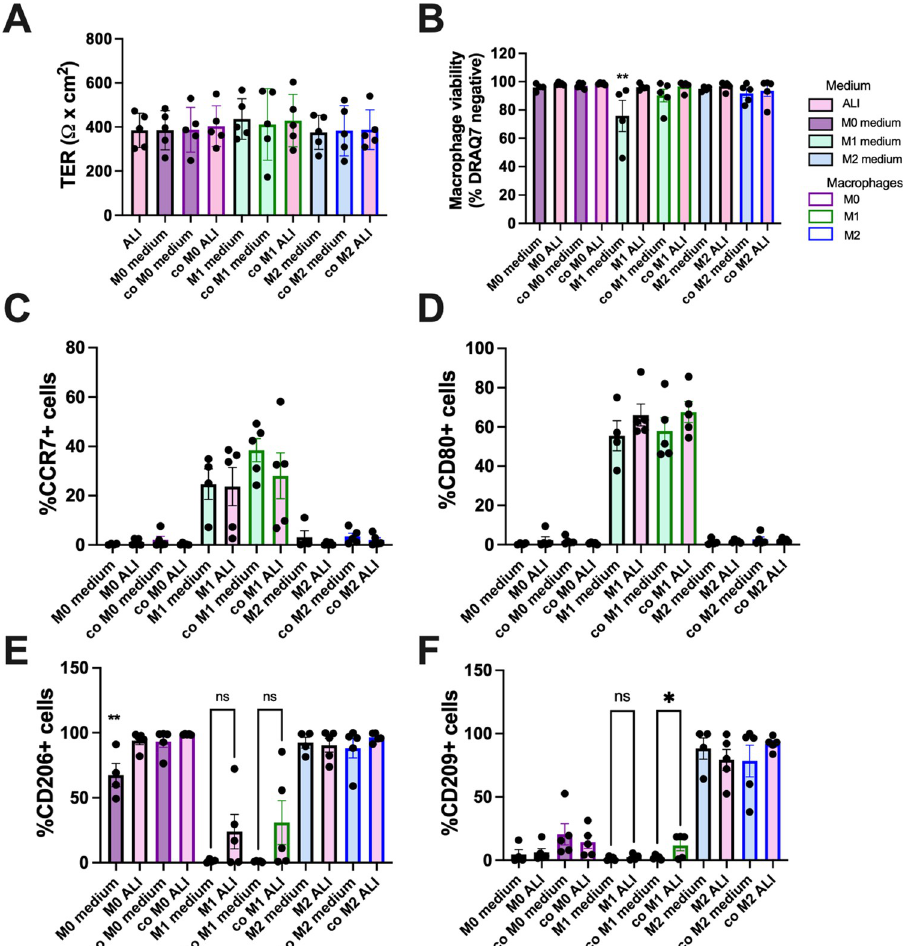
Fig 3. Assessment of phenotypic changes after co-culture of macrophages with HBECs. (A) TER of HBECs was measured after co-culture with macrophages or as monoculture in different medium types (M0, M1, or M2 medium, or ALI medium) for 72 hours. In this figure and the subsequent figures, each medium type is represented by a different colored bar, and if they are in co-culture the bar outline color corresponds to the macrophage type. No significant differences in TER were found as determined by ANOVA, n = 5. (B) Macrophage viability after monoculture in respective media (M0 medium, M1 medium, M2 medium for the corresponding macrophage type) or in ALI medium, or in co-culture (co) with HBECs in either medium. Viability was determined by flow cytometry by exclusion of DRAQ7 ™ dye. �� = p < 0.01 ANOVA with Tukey’s post hoc test compared to M0 in M0 medium, n = 4–5. (C-F) . Flow cytometric analysis of cell surface marker expression for M1 markers (CD80, CCR7) or M2 markers (CD206, CD209) in macrophages after monoculture or co-culture in M0, M1, or M2 medium, or in ALI medium. P < 0.05 as determined by ANOVA with Tukey’s post hoc tests (n = 4–5) where � p = < 0.05, �� = p < 0.01 as determined by ANOVA followed by Tukey’s post hoc test comparing M0 cultures, or where indicated, n = 4–5.